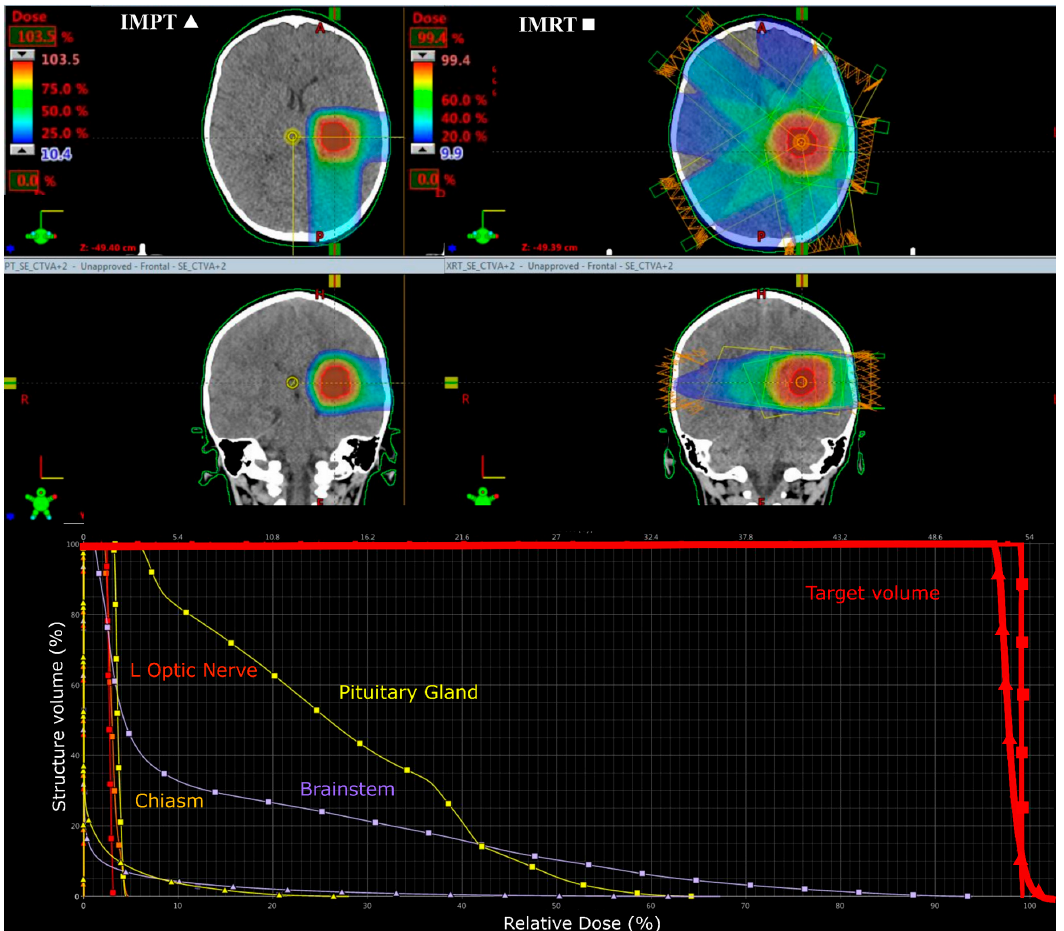
Figure 2. Colourwash dose distributions and dose–volume histograms for a 5-year-old male with supratentorial ependymoma. Typical planning beam arrangements and dose–volume histograms viewed on axial and coronal CT images for intensity-modulated proton therapy (IMPT) (left ▲ ) and intensity-modulated photon radiotherapy (IMRT) (right ■ ) plans.